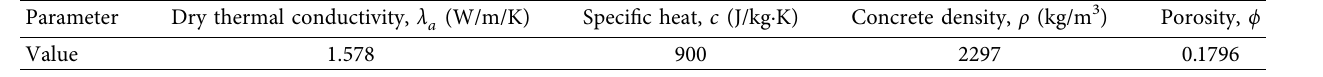
Table 6: Heat transfer physical parameters.